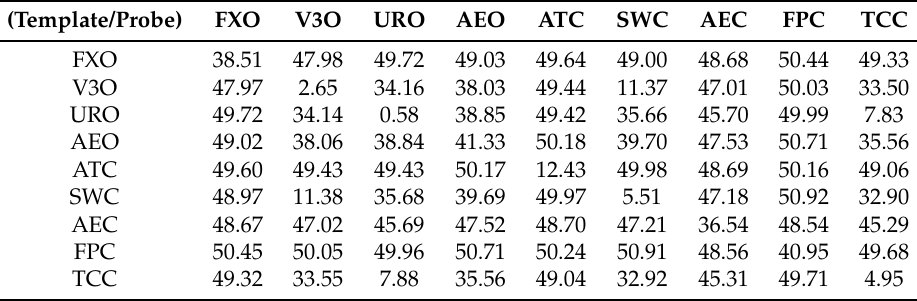
Table 6. EER (%) produced by the Bozoroth3